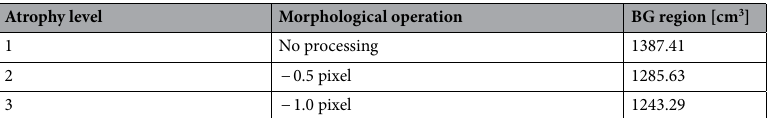
Table 1. Changes in the brain atrophy level and its volume. Background regions changed based on Level 1. The higher the level, the greater the brain atrophies.